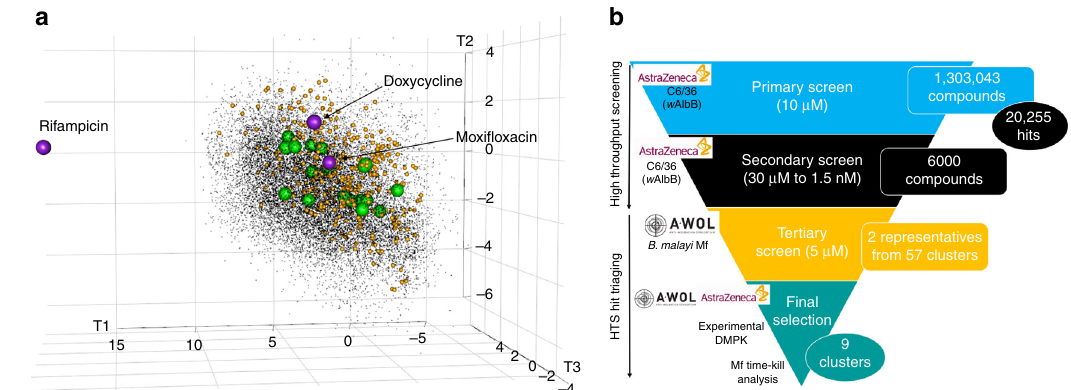
Fig. 2 Overview of the HTS. a Results in ChemGPS chemical space. Purple spheres represent examples of current anti- Wolbachia agents; black points represent the ~20,000 actives identi fi ed in the primary HTS; orange spheres represent the 360 compounds from the 57 clusters tested in the micro fi larial (Mf) assay; green spheres represent the 18 con fi rmed, potent hits. The position in ChemGPS space indicates a compound ’ s size, hydrophobicity/ hydrophilicity and fl exibility (T1, T2 and T3 de fi ned in ref. 21 ). The hits span a large proportion of the chemical space covered by the ~6000 compounds. The 3D plot was produced in R using the rgl library (http://cran.r-project.org). b The full screening campaign and triaging process. Each stage includes the total compounds screened (rectangular box on the right) and hits identi fi ed (circular box on the right). The screen used (C6/36 ( w AlbB) or Brugia malayi Mf) and screening location (AstraZeneca or A·WOL) are indicated on the left. Rational analysis was utilised at every stage based on cheminformatics and available